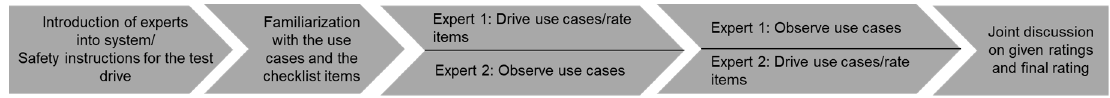
Figure 2. Simplified flow chart of the test procedure.